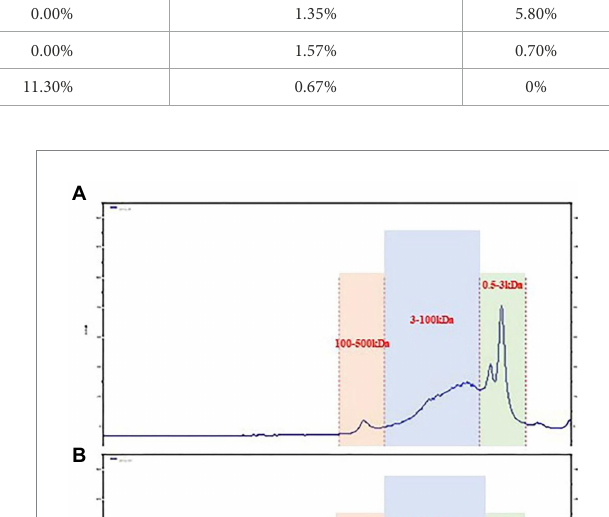
TABLE 1 Chemical components and monosaccharide composition of LSP.